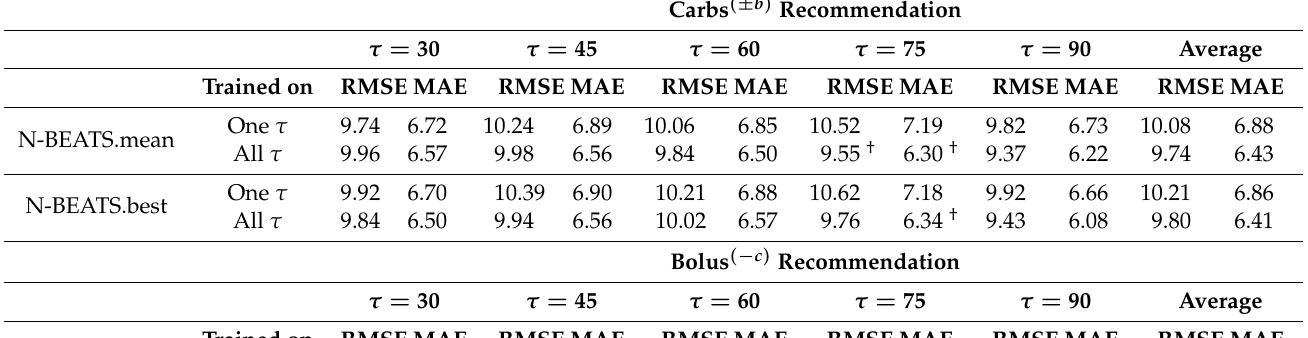
Table 12. Comparison between models trained on all prediction horizons vs. one prediction horizon τ , when evaluated on the prediction horizon τ . The symbol † indicates a p -value < 0.05 when using a one-tailed t -test to compare against the one prediction horizon results.